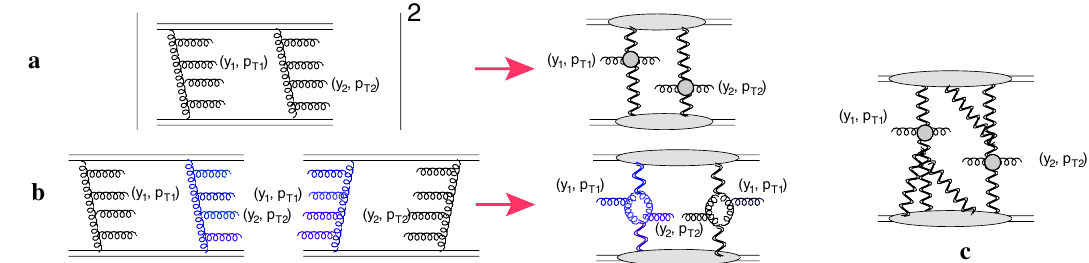
Fig. 1 Mueller diagrams[39] for two partonic showers production. a The square of the production amplitudes, while b corresponds to the interference diagram which leads to the Bose–Einstein correlations. The wavy lines show the BFKL Pomeron [40–43], while the helical